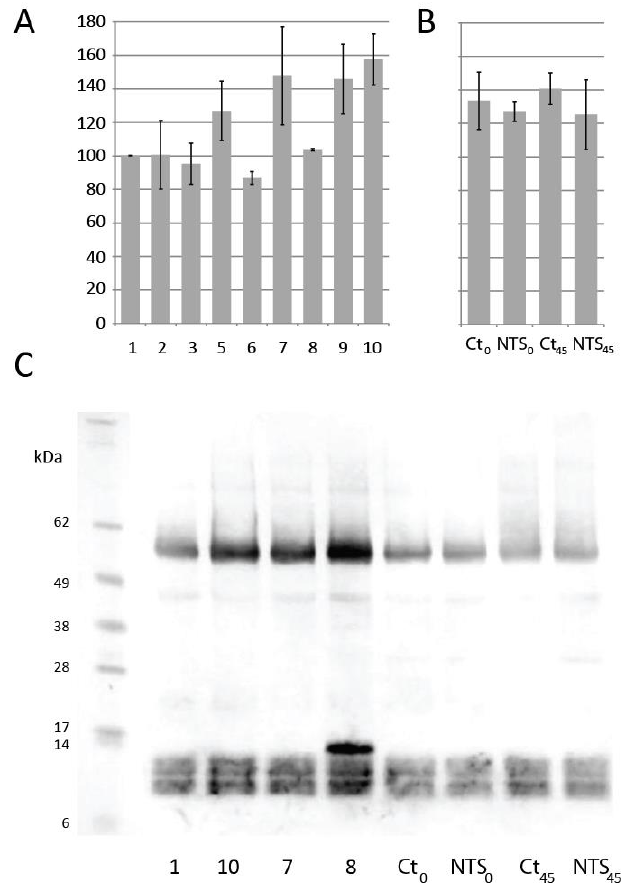
Figure 4. ( A ) Dough soluble thiol content measured as by Ellmann reagent in samples 1 to 10, corresponding to the conditions detailed in Figure 2. ( B ) Yeast-containing dough soluble thiol content measured as by Ellmann reagent in dough used for baking tests. Time point 0 corresponds to dough sampled just after mixing, and t = 45 min to dough just before baking, after development. Control sample value was set to 100%. ( C ) Western blot profile of dough extract with anti-wheat Trxh1 polyclonal antibodies. A marker in the first lane (size in kDa) was added for reference from the picture of the Ponceau-stained membrane before immunodetection.